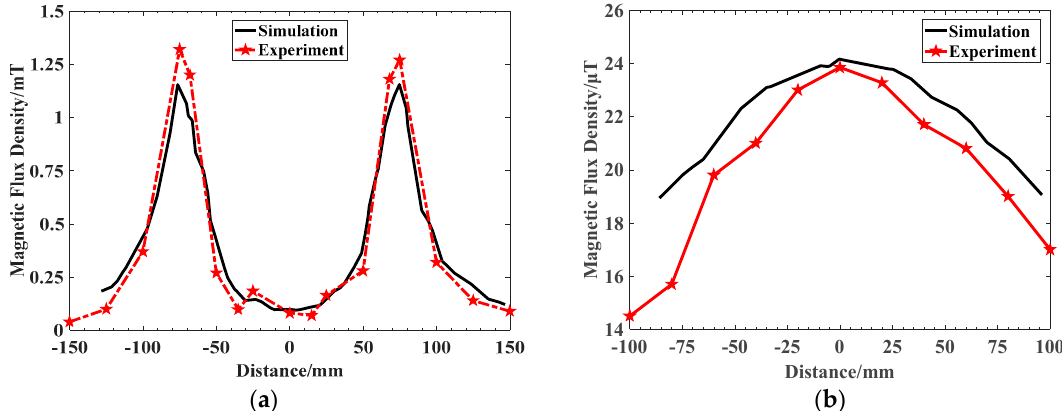
Figure 13. Magnetic flux density versus distance of experiment and simulation comparison. ( a ) Radial position 10 mm above the receiving coil with composite shielding coupler on receiving coil coupler. ( b ) Axial 250 mm outside the magnetic coupler with composite shielding coupler on receiving coil.